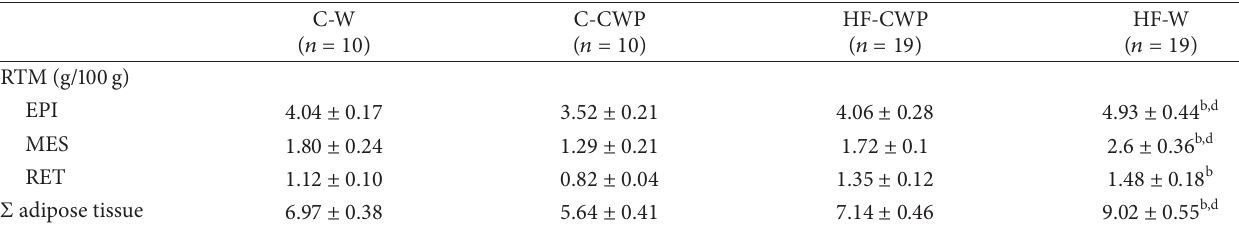
Figure 4: Protein expression of HSL (a); ATGL (b); perilipin A (c); ABHD-5 (d); and pAMPK (e) in the mesenteric adipose tissue. The data are expressed in arbitrary units (A.U). Data submitted with an average ± EPM. (A) C-W versus C-CWP; (B) C-W versus HF-W; (C) C-CWP versus HF-CWP; and (D) HF-CWP versus HF-W. ( 𝑃 < 0.05 ). Table 3: Total mass (g), delta on the body mass gain (g/100g body weight), and relative mass of tissue (RMT) (g/100g body weight) of mice treated with high fat diet (HF) or control normocaloric (C) associated with gavage of coacervate (CWP) or water